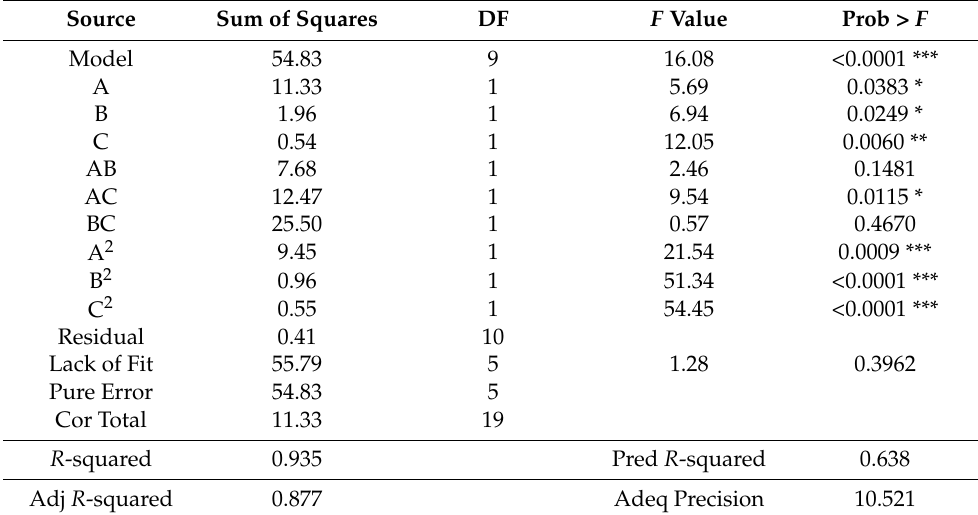
Table 8. Analysis of variance (ANOVA) for central composite design (CCD) for biosurfactant production using WCO as